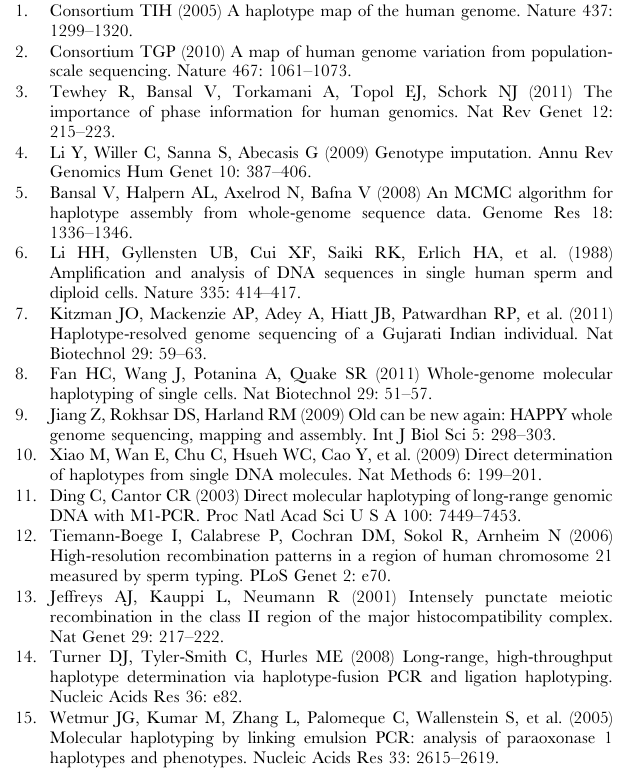
Figure S1 Intensity distributions of allelic dropouts compared to multiplex amplification. Distribution of the fluorescence intensity of the beads amplified with one or two targets. The intensity was normalized for the two fluorphores used per polymorphism. Figure S2 Schematics of the bead analysis to extract the beads’ intensities from the pixel information of an image. Figure S3 Distribution of average intensities of two fluorescent channels. The red, green, blue and pink cluster represent the 00, 10, 01, and 11 class respectively. It can be observed that it is difficult to delimit the 00 from the other 3 classes. Figure S4 MvA plot with normalized intensities of two fluorescent channels. Figure S5 Normalized intensities of two fluorescent channels with the number of beads estimated for each of the four clusters.